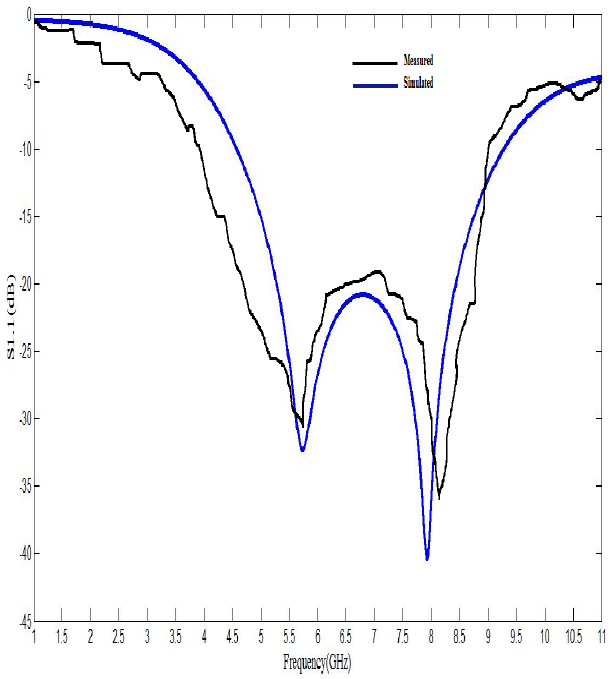
Figure 9 Simulated Return Loss as Compared with Measured Return Loss